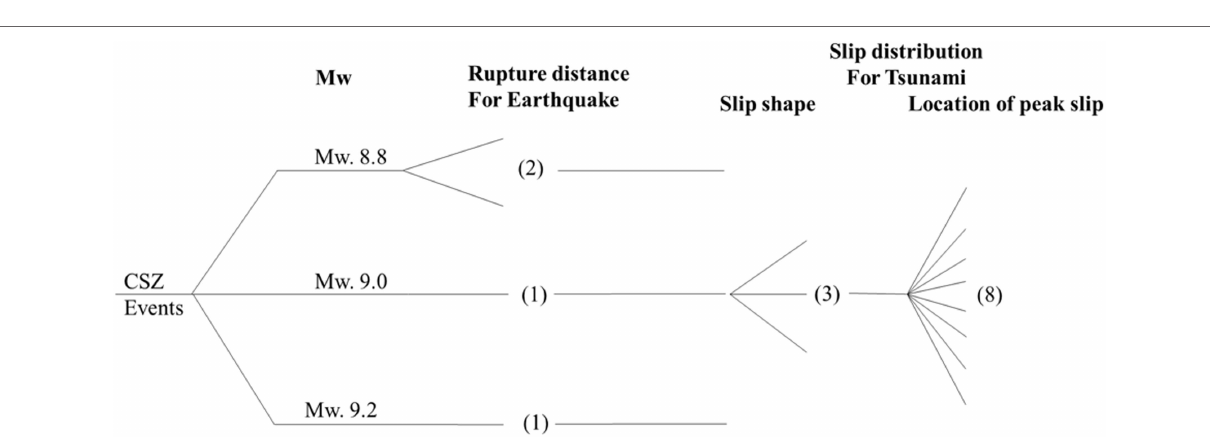
FIGURE 6 | Logic-tree model for full-rupture event at Cascadia subduction zone (CSZ). Each number in parenthesis provides the number of branches (scenario cases) considered depending on the characteristics of the rupture events (see details in the study by Park and Cox,